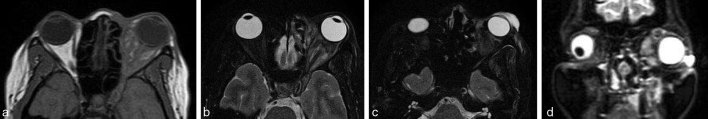
Axial T
1 weighted images show fat stranding in the retro-orbital, orbital apex and left cavernous sinus regions with minimal proptosis of the left globe (a). Axial T
2 weighted fat-saturated images (b, c) show extensive fat stranding in the retro-orbital region, ill-defined isointense to hypointense soft tissue along the medial wall of the left orbit and intraconal retro-orbital space extending to the orbital apex. On short tau inversion-recovery coronal images (d), the extraocular muscles appear oedematous. Left internal carotid artery flow void is small in calibre with adjacent soft tissue thickening in the left cavernous sinus (a–c). A small focal hyperintense collection is seen in the left preseptal space (c, d).